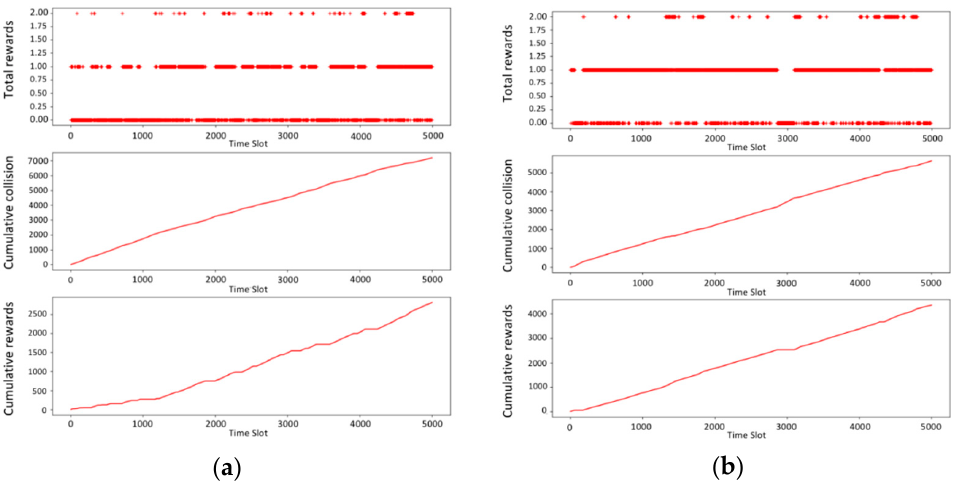
Figure 5. When K = 2 and N = 3, the total reward, cumulative collision, and cumulative reward for ( a ) the first 5000 time slots and ( b ) 50,000 to 55,000 time